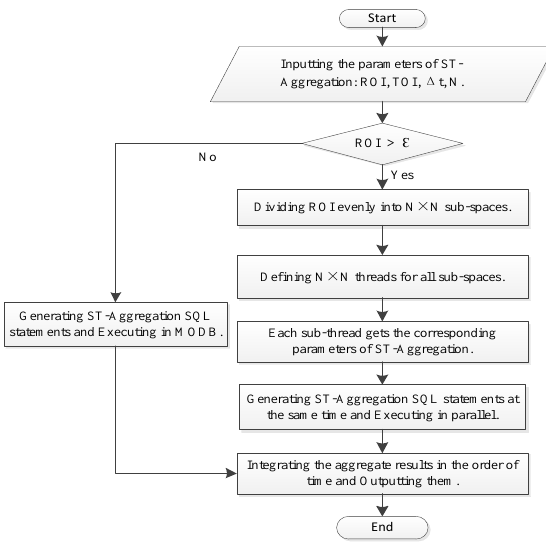
Figure 3. Parallel algorithm flow of spatiotemporal aggregation query over moving